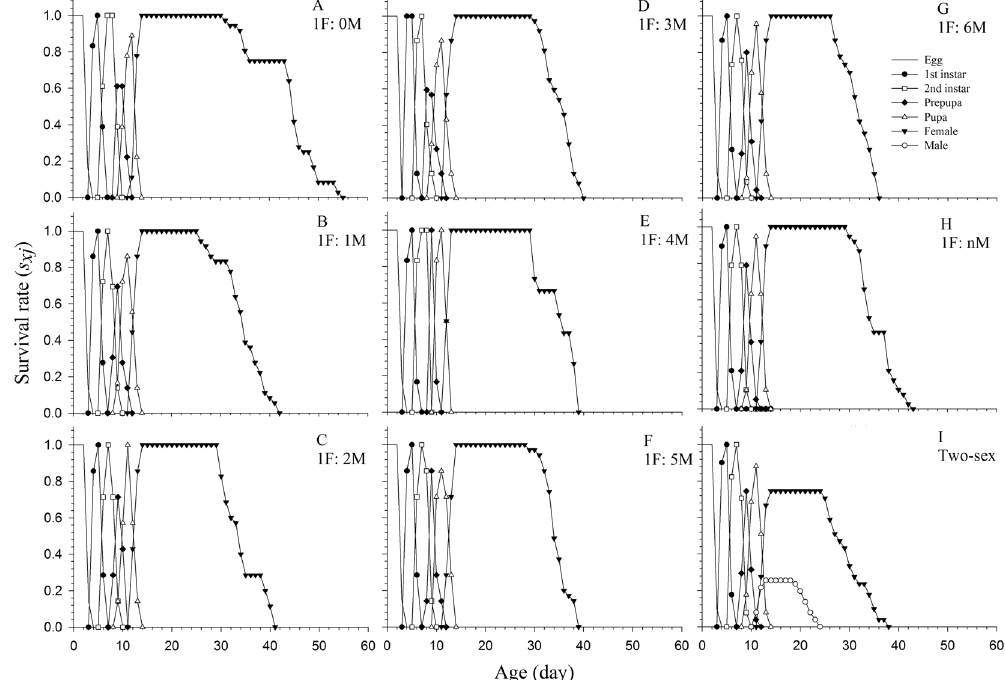
Figure 1. Age-stage survival rate ( s xj ) of Frankliniella occidentalis at different arrhenotokous sex ratios and bisexual population. A = 1 F:0 M, B = 1 F:1 M, C = 1 F:2 M, D = 1 F:3 M, E = 1 F:4 M, F = 1 F:5 M, G = 1 F:6 M, H = 1 F:nM, I =